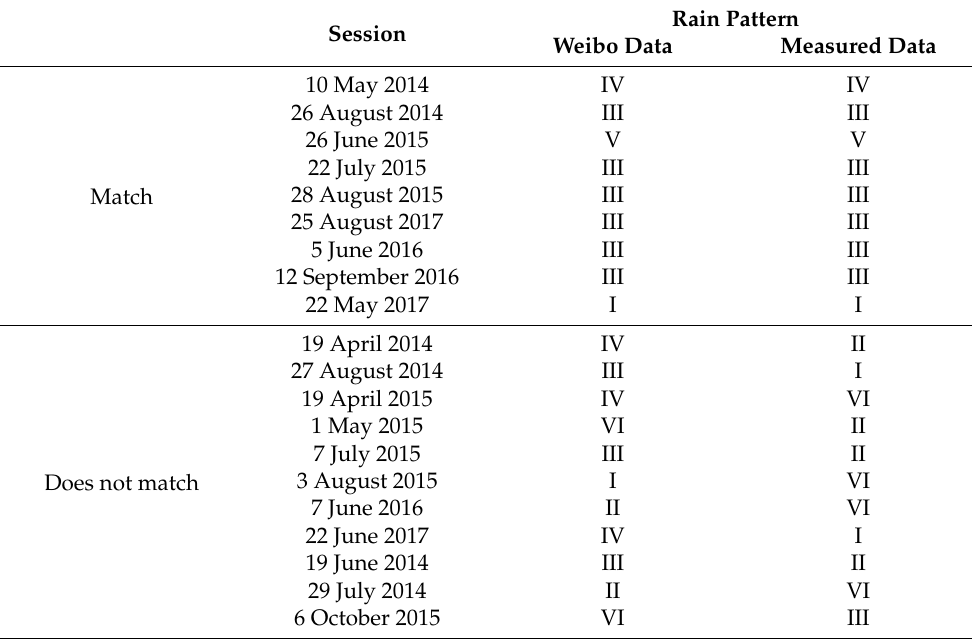
Table 5. The matching conditions of the two groups of data are shown in Table 6. Table 6. Comparison results of the rainfall patterns identified by the two kinds of